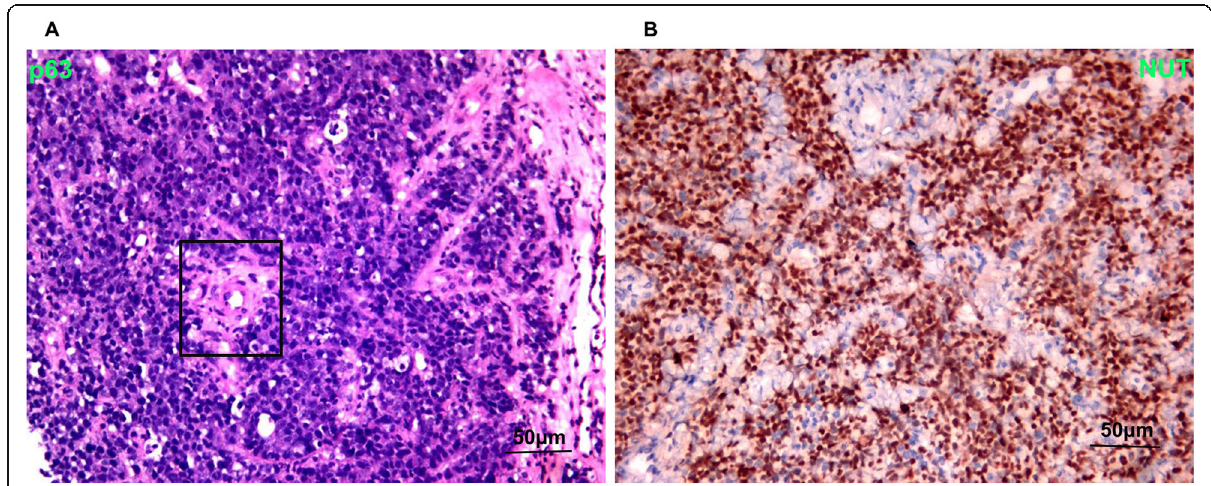
Fig. 3 NUT midline carcinoma as a primary lung tumor. A : The NMC CT on Sept. 9th 2020. B : The NMC CT on Sept. 25th 2020. C : The NMC CT on Nov. 9th